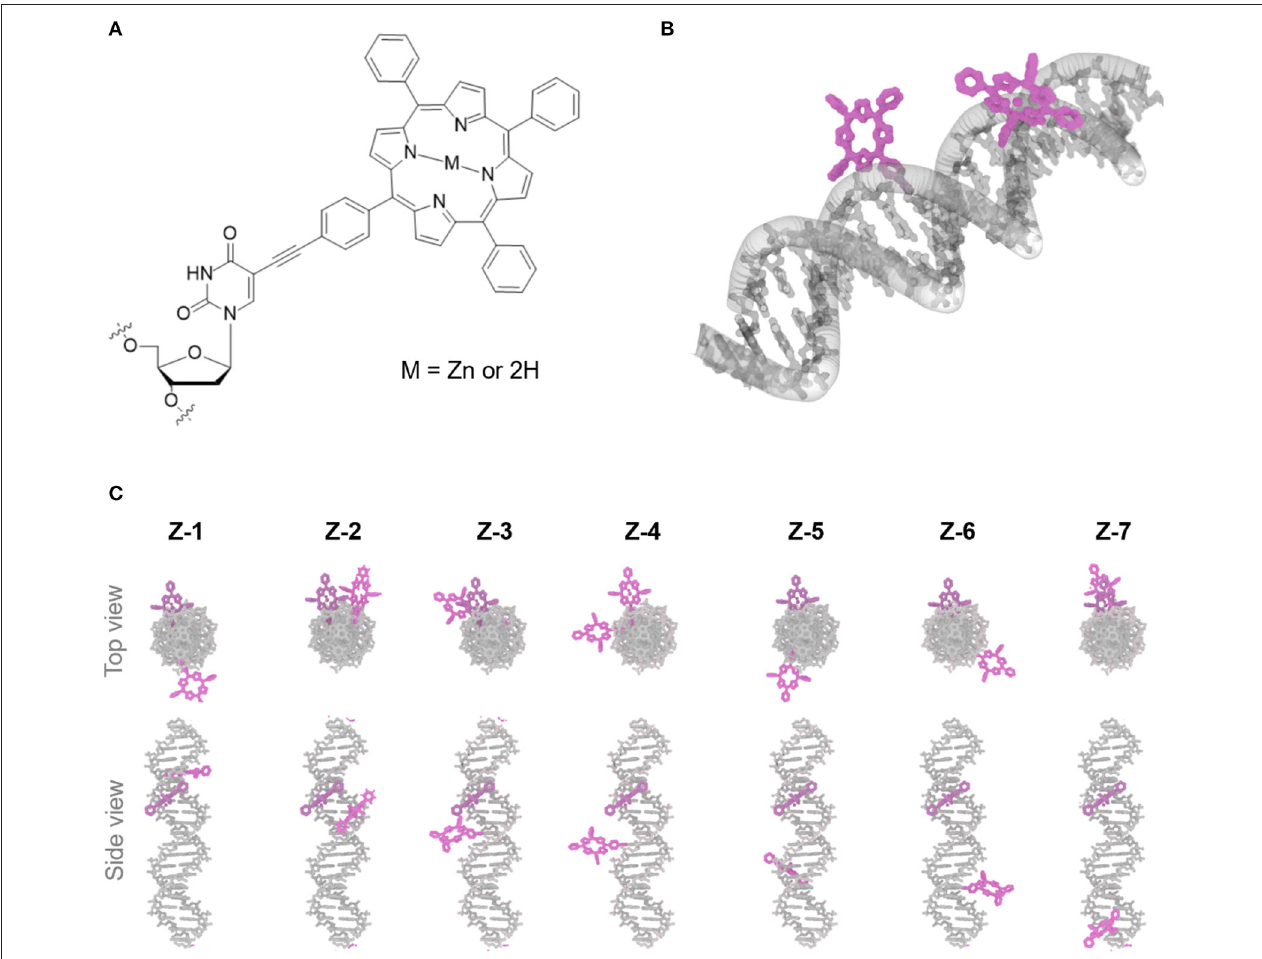
FIGURE 1 | (A) Chemical structure of porphyrin DNA modification connected via a rigid acetylene linker, the central cavity contains either a Zn or free-base (2H). (B) 3D rending of duplex DNA (gray) modified with two porphyrin molecules (purple). (C) Top and side view of porphyrin-DNA duplexes assayed containing Zn-porphyrin (donor) and 2H-porphyrins (acceptor) (purple), the Zn-porphyrin position is held constant, whilst the 2H-porphyrin is varied, giving rise to seven different porphyrin-porphyrin distances and angles.